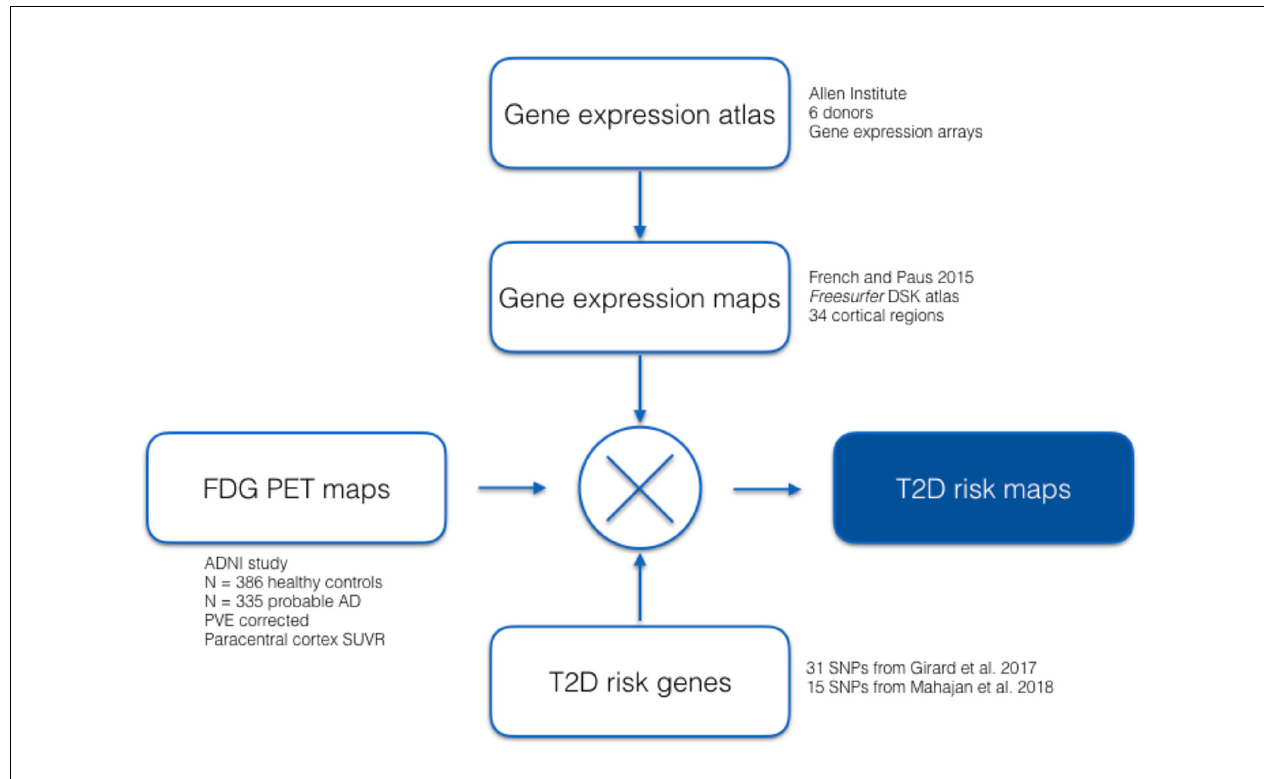
FIGURE 1 | Flowchart describing the datasets and proposed